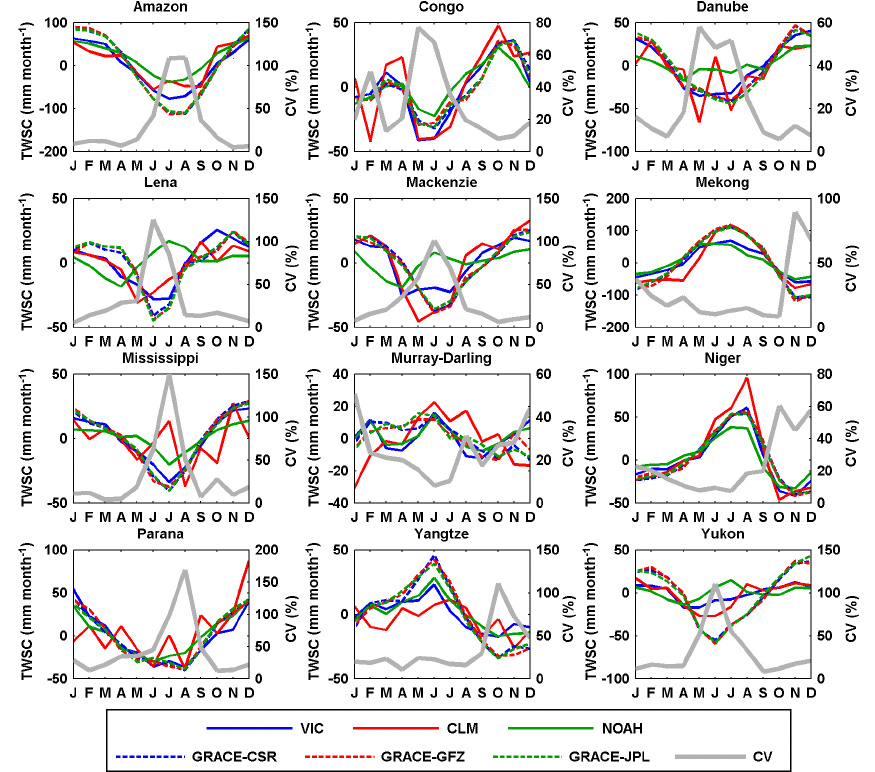
Figure 10. Seasonal cycle of TWSC from different products over 12 representative large basins for